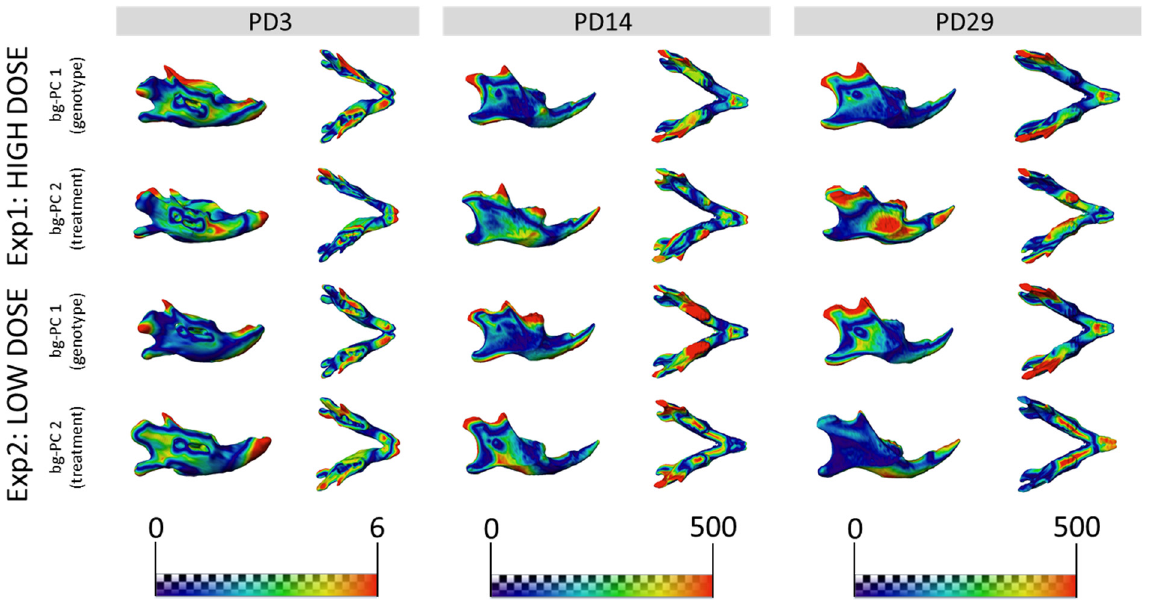
Figure 6. Mandibular morphological differences associated with genotype and treatment effects. Heatmaps showing the shape differences between the morphings on the positive and negative extreme of bg ‐ PC1 (labeled as genotype) and the positive and negative extreme of bg ‐ PC2 (labeled as treatment). Heatmaps are presented at PD3 (left), PD14 (middle), and PD29 (right) for experimental setting 1 (top) and experimental setting 2 (bottom). Red areas indicate anatomical regions with the largest shape differences. Heatmaps were derived using the shape associated with the positive extreme of bg ‐ PC1 or bg ‐ PC2 as the reference shape, and the shape associated with the negative extreme as the target shape.